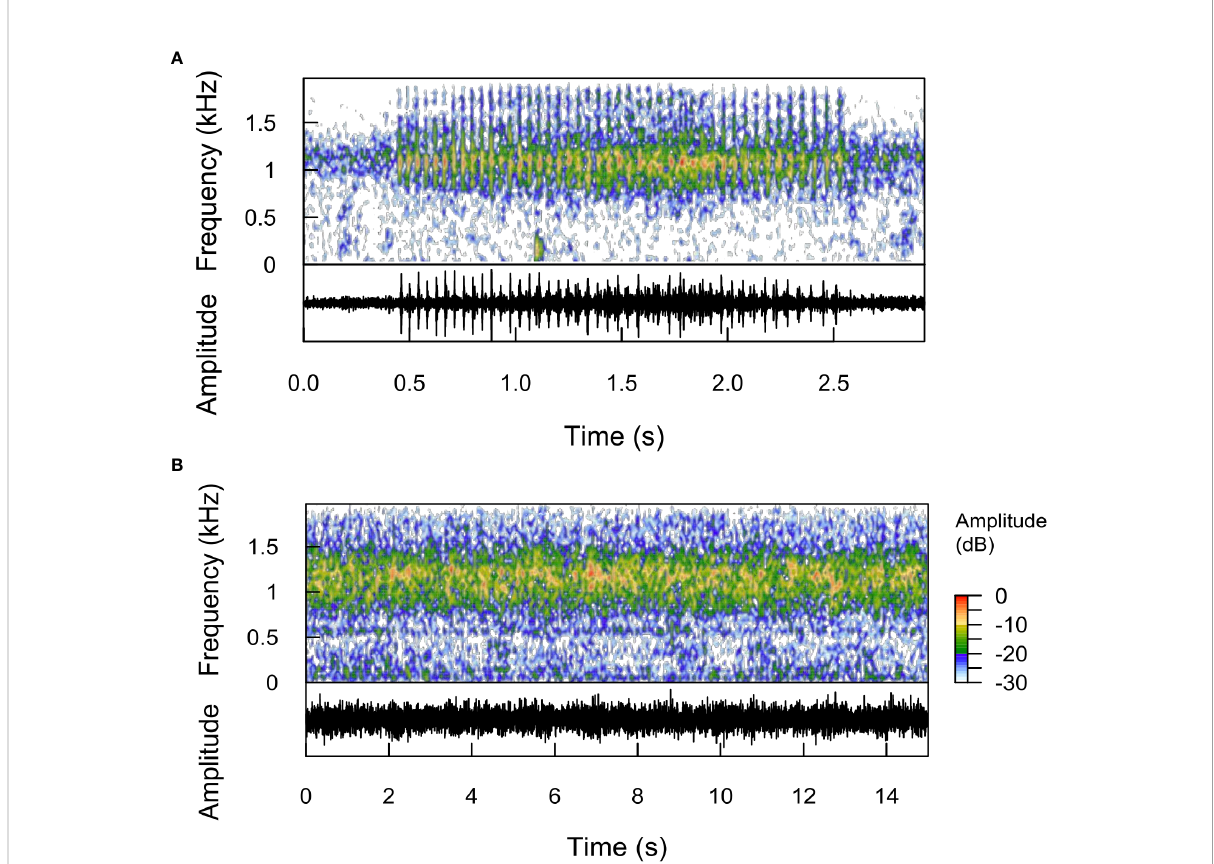
FIGURE 10 Putative cusk-eel (A) chatter calls and (B) chorus. Spectrogram and corresponding oscillograms are shown. Putative cusk-eel chatter sounds have many high frequency pulses (~25 per second). (A) Two putative calls, overlapping and in succession. At ca. 1.9 s, the second call, with lower pulse amplitudes and pulses that do not extend as high in frequency are evident. After sunset, (A) isolated calls quickly begin to overlap in time and form a (B) chorus with most energy concentrated between 900-1500 Hz. Chorus intensity began to wane at ca.